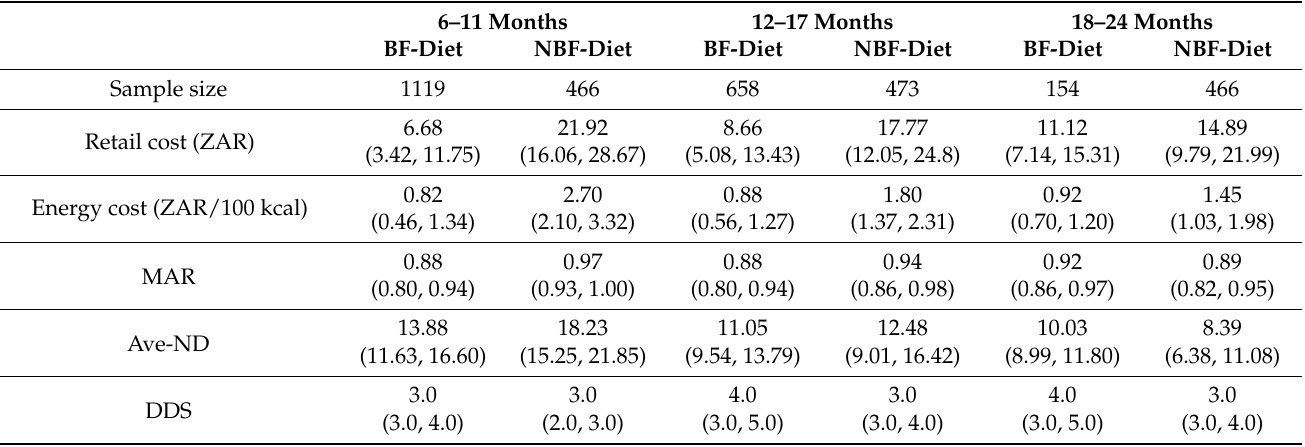
Table 1. Median (P25, P75) for cost and diet quality indicators per age group and type of